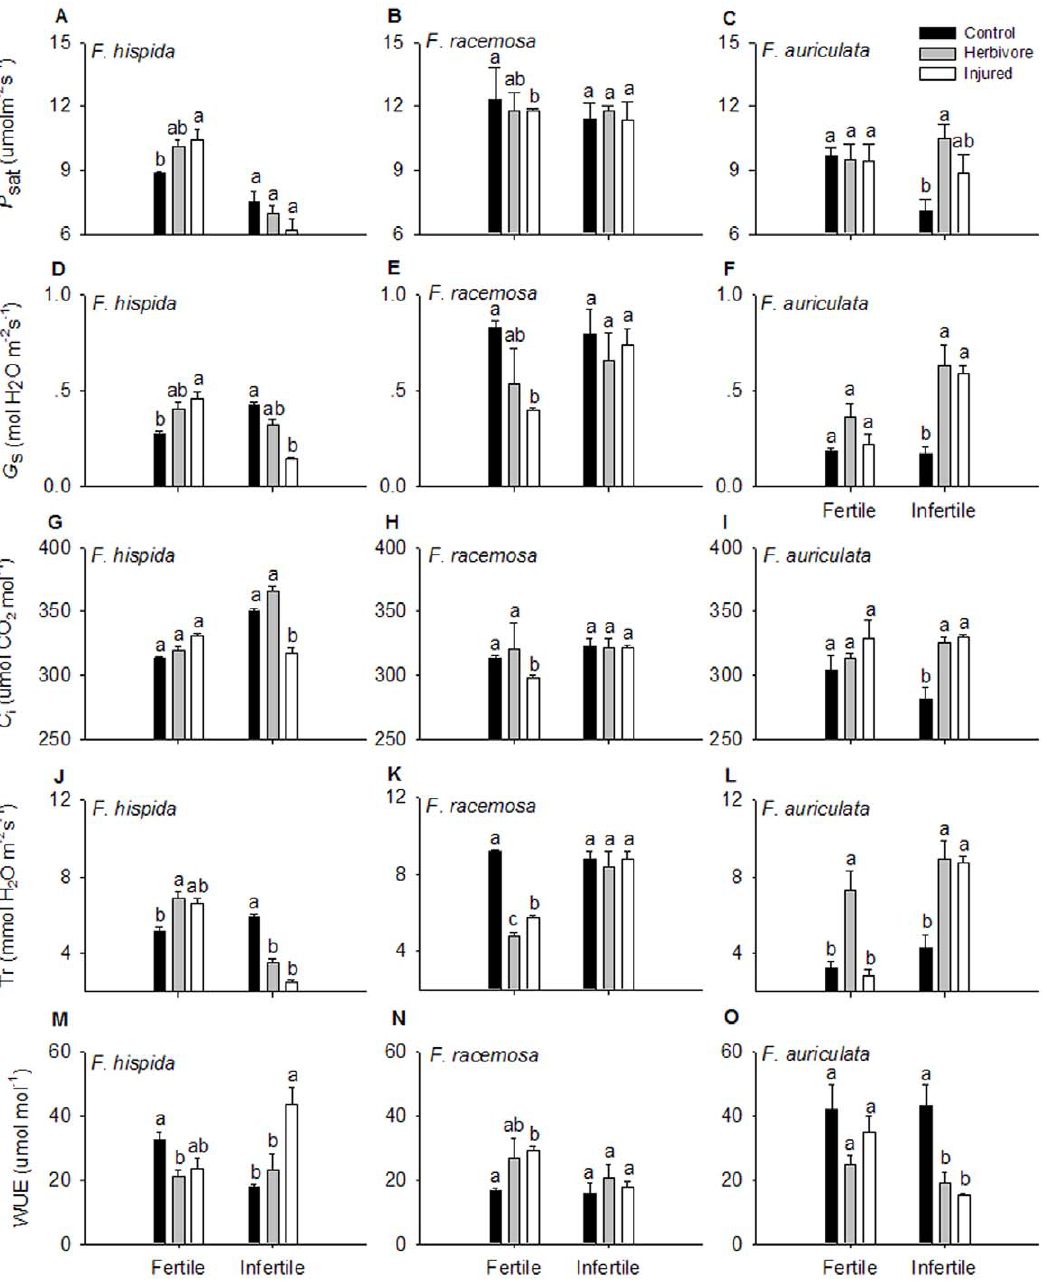
Figure 5. Effect of treatments on photosynthetic characteristics of Ficus saplings under two soil nutrient levels. Significant differences between treatments are marked with different letters (mean 6 SE, n=3, P , 0.05). P sat , light saturated photosynthetic rate ( m mol m 2 2 s 2 1 ); G s , stomatal conductance (mol H 2 O m 2 2 s 2 1 ); WUE, water use efficiency ( m mol mol 2 1 ).